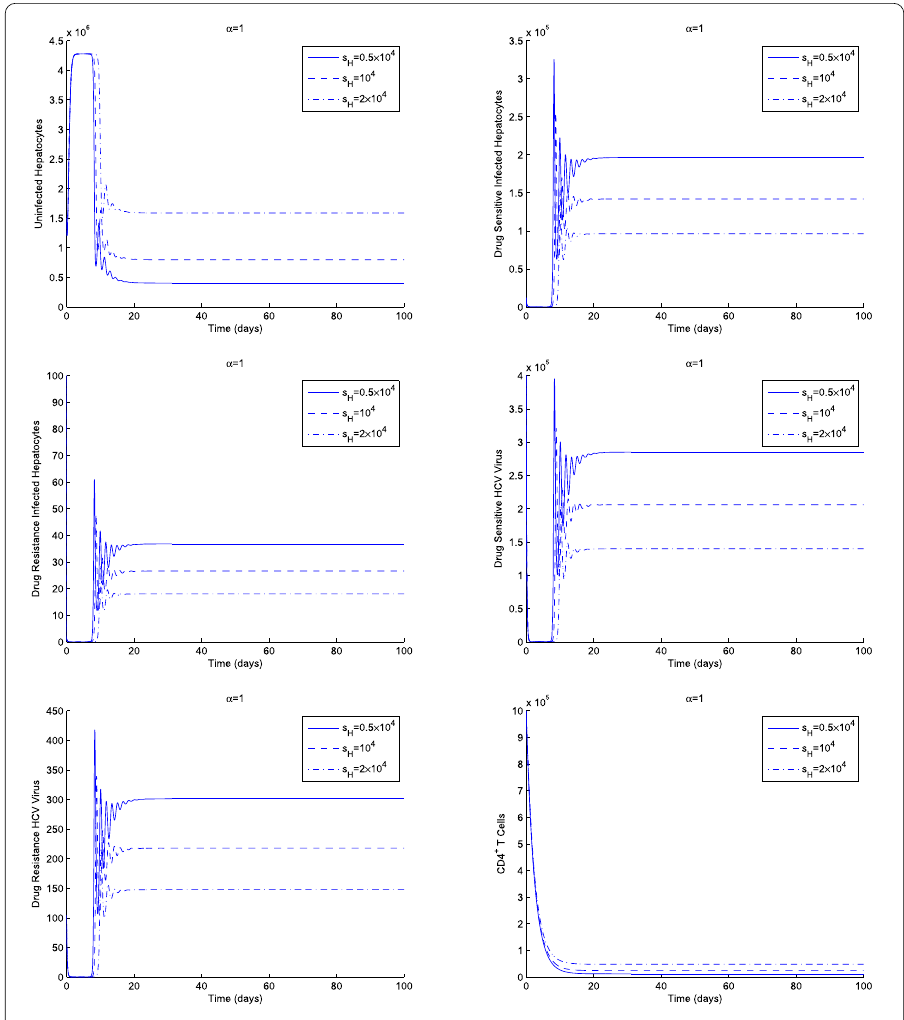
Figure 9 Dynamics of the variables of system (1) for different values of s H , the CD4 + T cells recruitment rate, and α = 1.0. Parameter values are in Table 1 and initial conditions are given in the